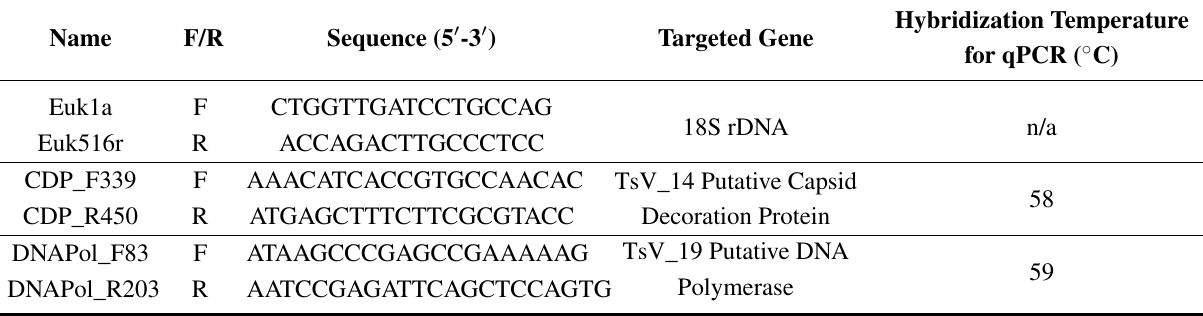
Table 1. List of primers used in this